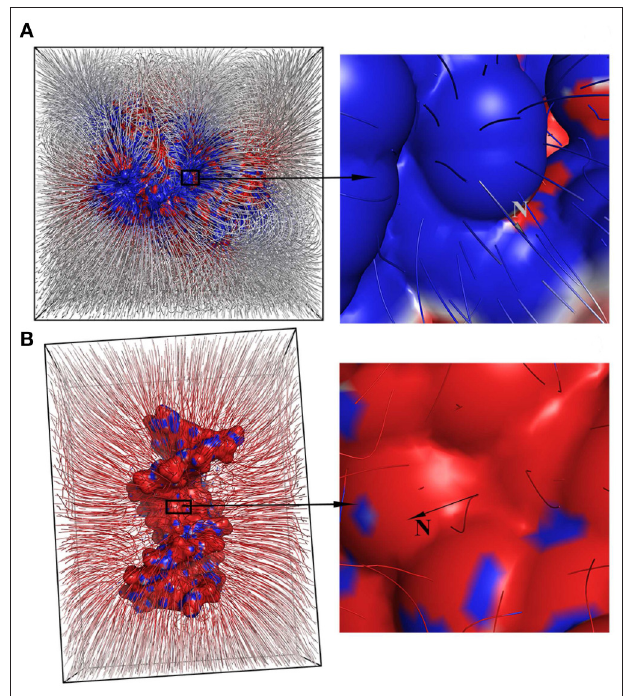
FIGURE 5 | Color-coded electrostatic surface where red indicates negatively charged regions of the surface, white neutrally charged and blue positively charged one. Simulated electrostatic field lines are displayed as hairs on the surface of the protein (A) and the DNA (B) . Hairs are generated by the adaptive Poisson-Boltzmann solver and highlight how variations of the field lines on the surface describe the charge distribution pattern on the surface. The right side of the figure shows the position of the surface normal N and electrostatic